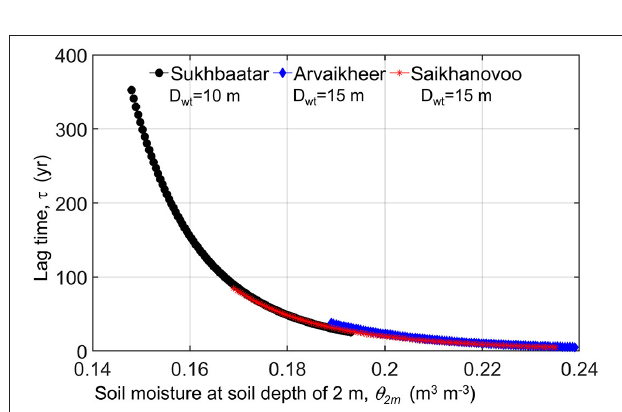
FIGURE 6 | Relationship between soil moisture at a soil depth of 2m ( θ 2m ) simulated in HYDRUS-1D and lag time τ in Sukhbaatar (black circles), Arvaikheer (blue diamonds), and Saikhanovoo (red asterisks).